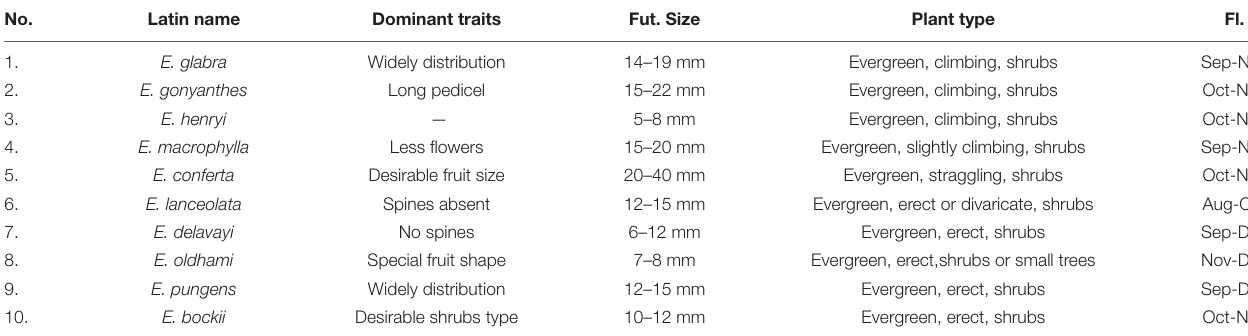
TABLE 2 | Ten resources of Chinese wild Elaeagnus L. species with the potential to develop into fruit crops.